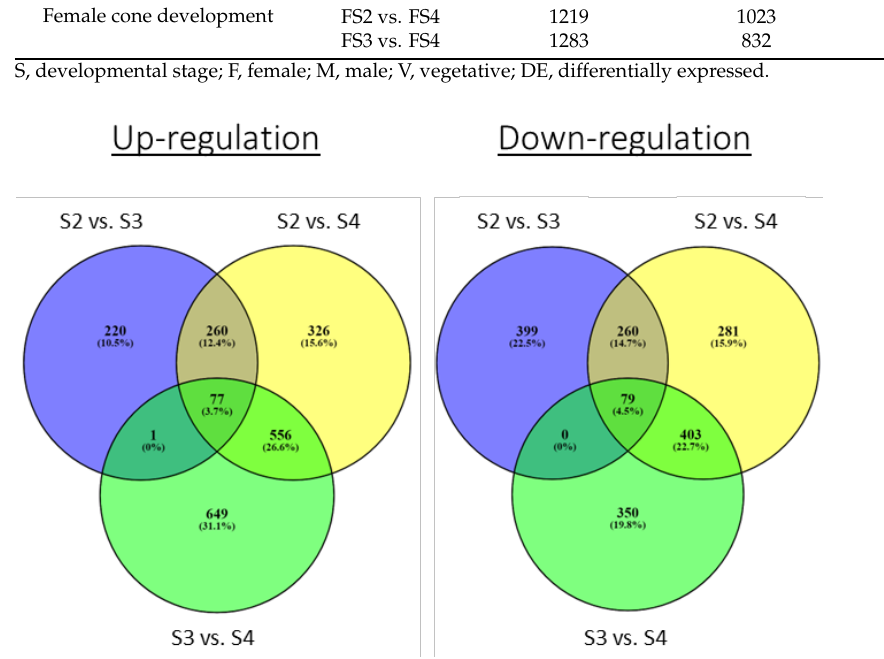
Figure 3. Venn diagram of up-regulated and down-regulated genes showing shared genes between the female cone three developmental stages. S2–S4, developmental the female cone three developmental stages. S2–S4, developmental stages.